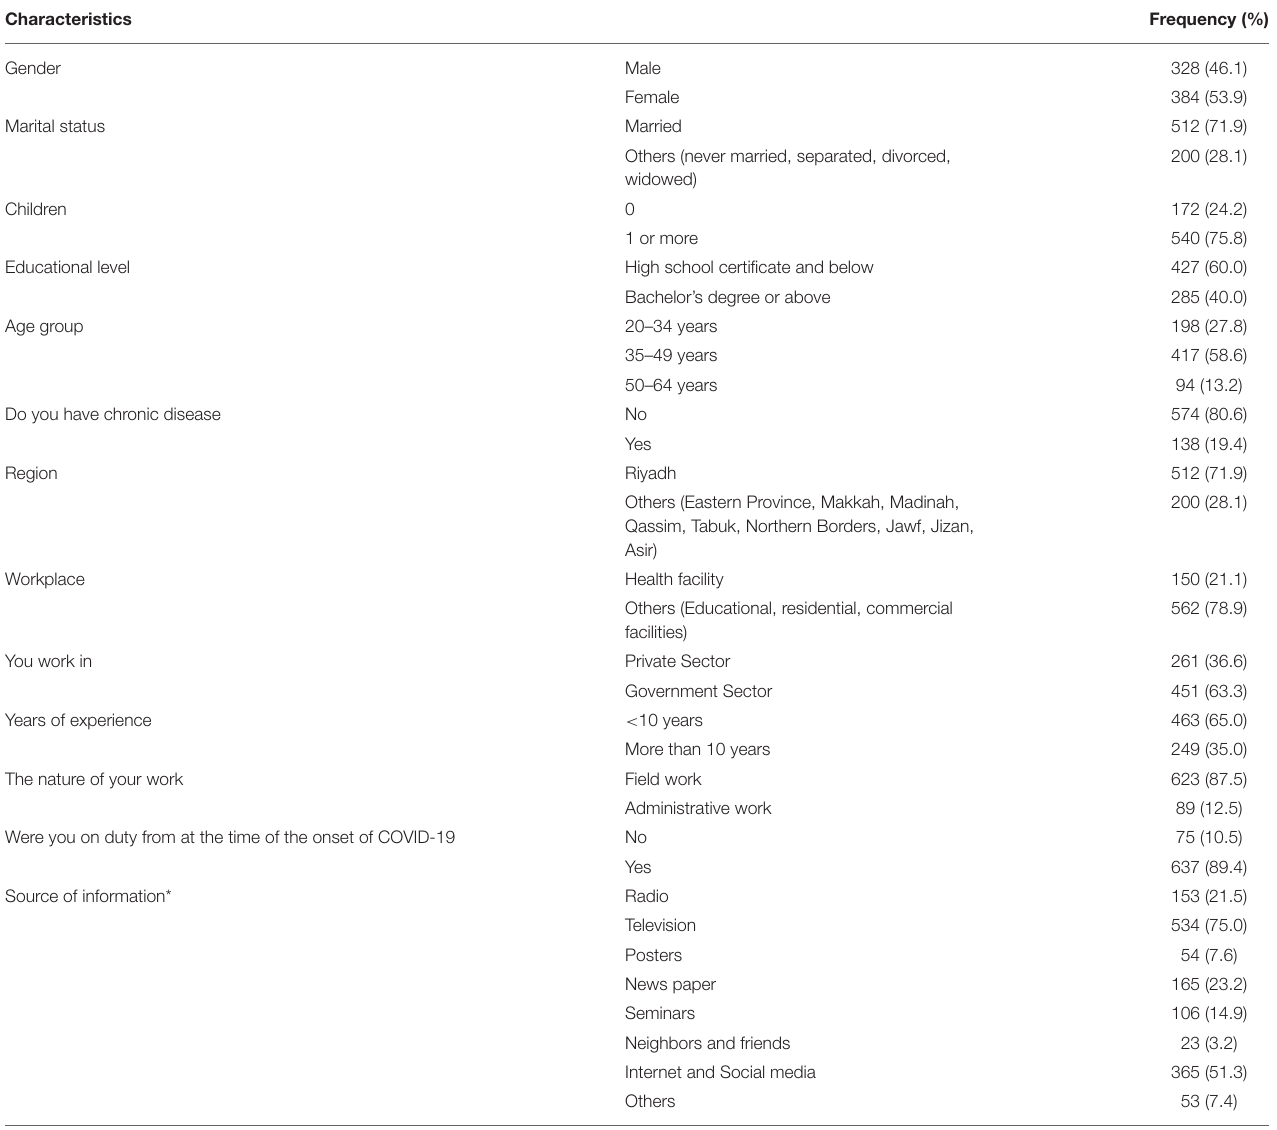
Table 2 | Sociodemographic characteristics of participants ( N = 712).